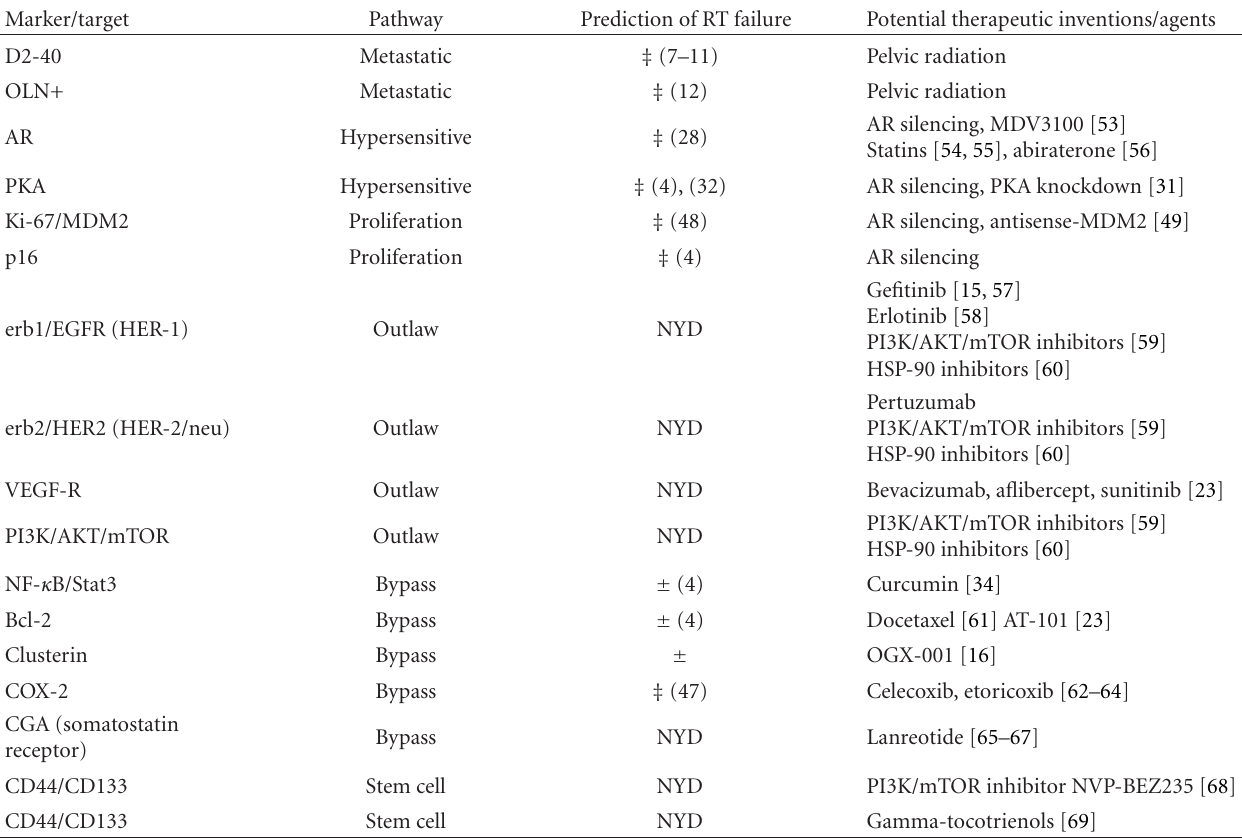
Table 1: Selection of potential markers/targets and pathways implicated in the development of radioresistant prostate cancer, their significance in predicting radiation therapy (RT) failure, and potential therapeutic